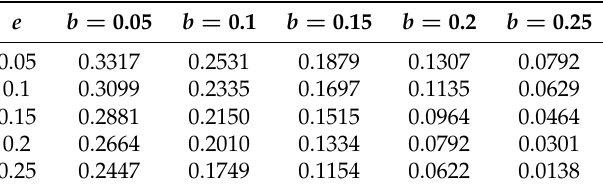
Table 6. Maximum allowable upper bounds α of Example 1.